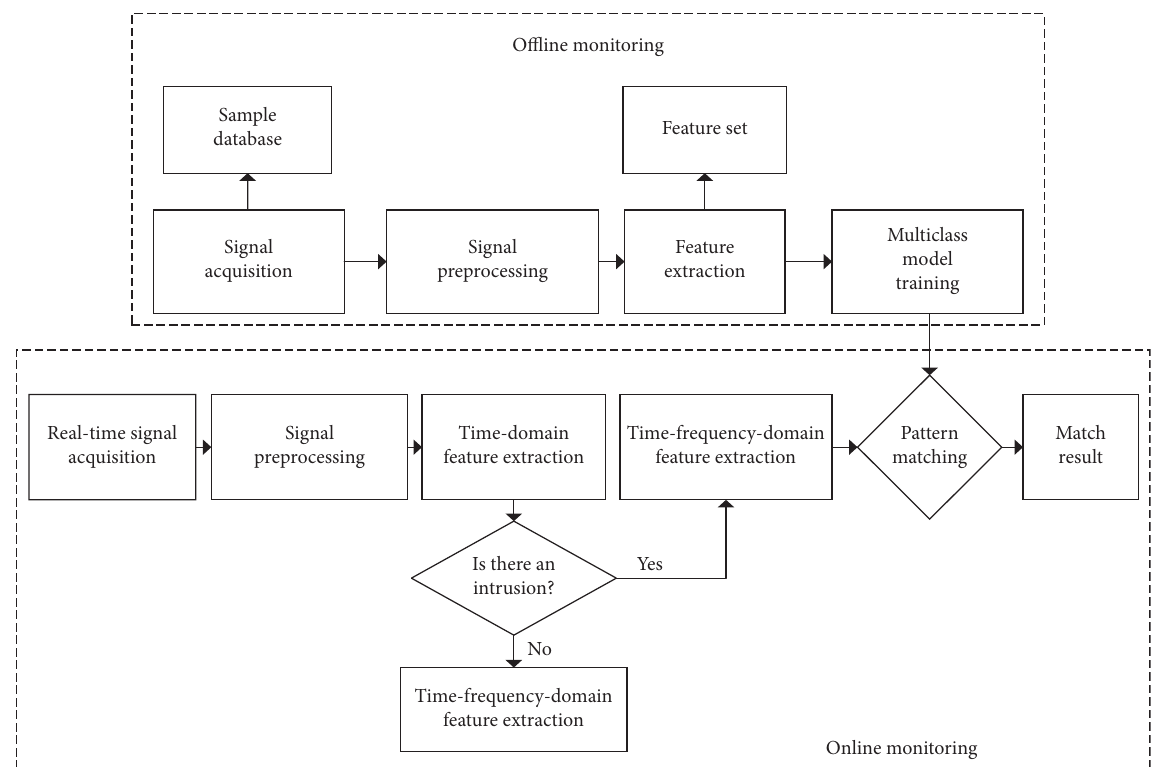
Figure 12: Block diagram of the data processing